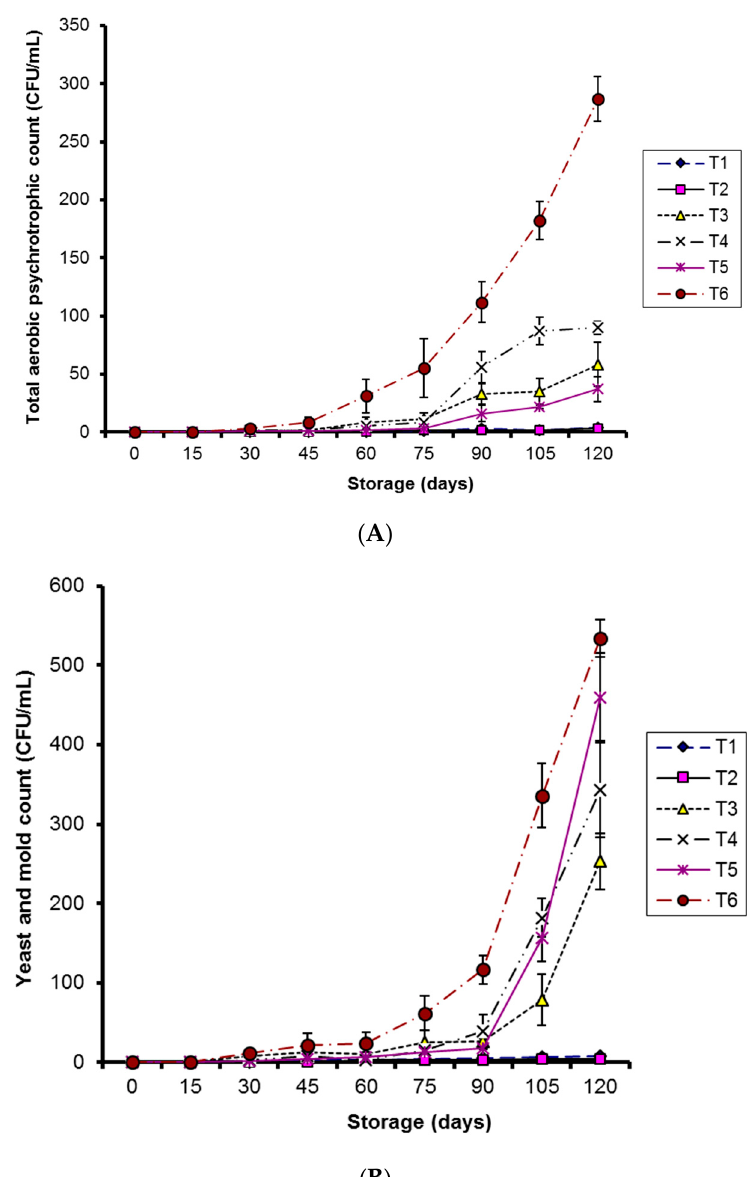
Figure 11. ( A ) Effect of CMC and guargum-based silver nanoparticle coatings on the total aerobic psychrotrophic count in kinnow fruit stored at 4 and 10 °C during storage. The vertical bars represent standard error of the means. Values represented as mean ± SE of three replicates; ( B ) Effect of CMC and guargum-based silver nanoparticle coatings on the yeast and mold count in kinnow fruit stored at 4 and 10 °C during storage. The vertical bars represent standard error of the means. Values represented as mean ± SE of three replicates.